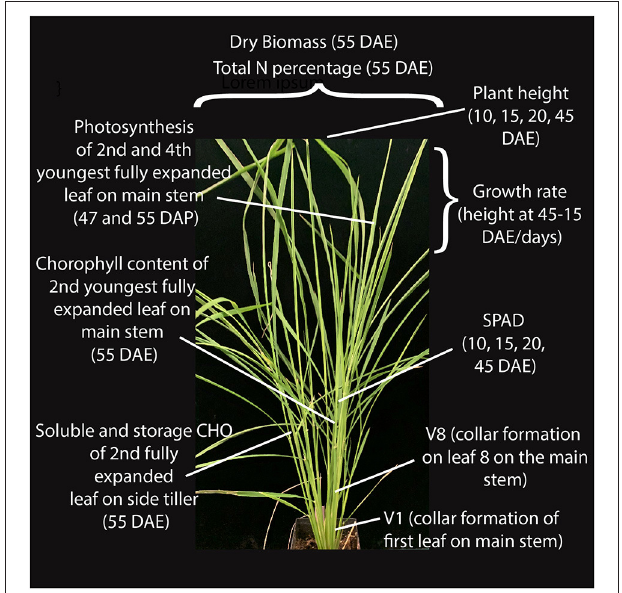
FIGURE 1 | Growth and physiological traits measured at different stages of vegetative growth in weedy rice.